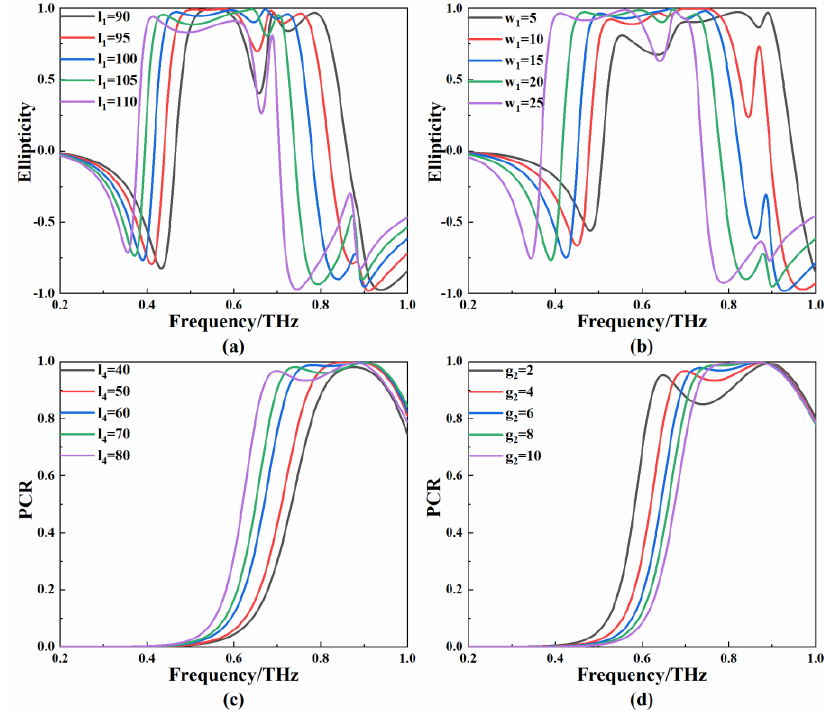
Figure 11. ( a ) Ellipticity corresponding to different lengths of l 1 ; ( b ) ellipticity corresponding to different lengths of w 1 ; ( c ) PCR corresponding to different lengths of l 4 ; ( d ) PCR corresponding to different lengths of g 2